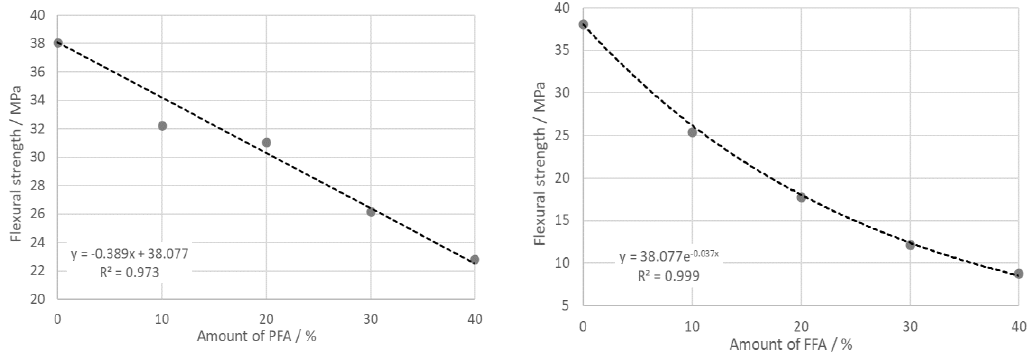
Figure 11. The flexural strength of PF ( left ) and FF ( right ) samples (measured at the room temperature after firing at 1100 °C).